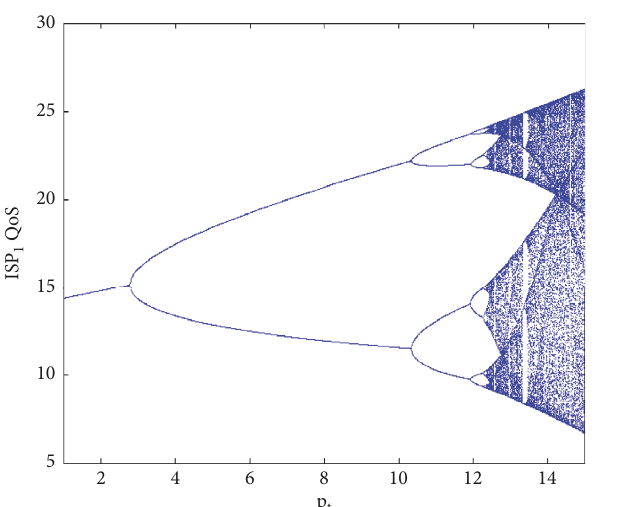
Figure 15: Bifurcation diagrams of p